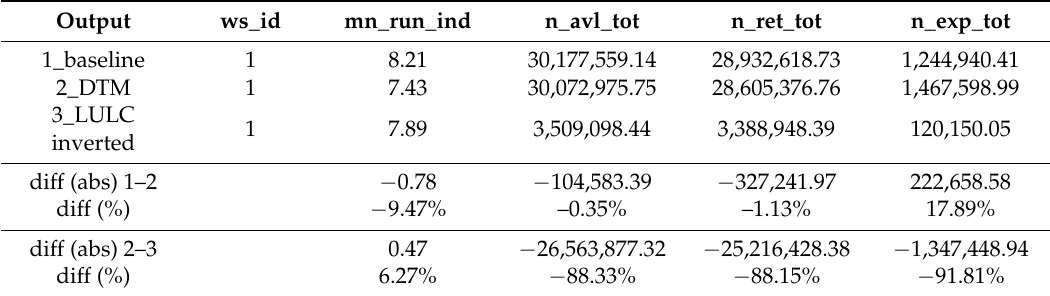
Table 3. Table of biophysical values in kg of nitrogen at the catchment area. ws_id is the watershed identification number, mn_run_ind is the mean runoff index, n_avl_tot is the total amount of nitrogen in the catchment, n_ret_tot is the total amount of nitrogen retained by the landscape, and n_exp_tot is the total amount of nitrogen exported to the stream in the watershed.